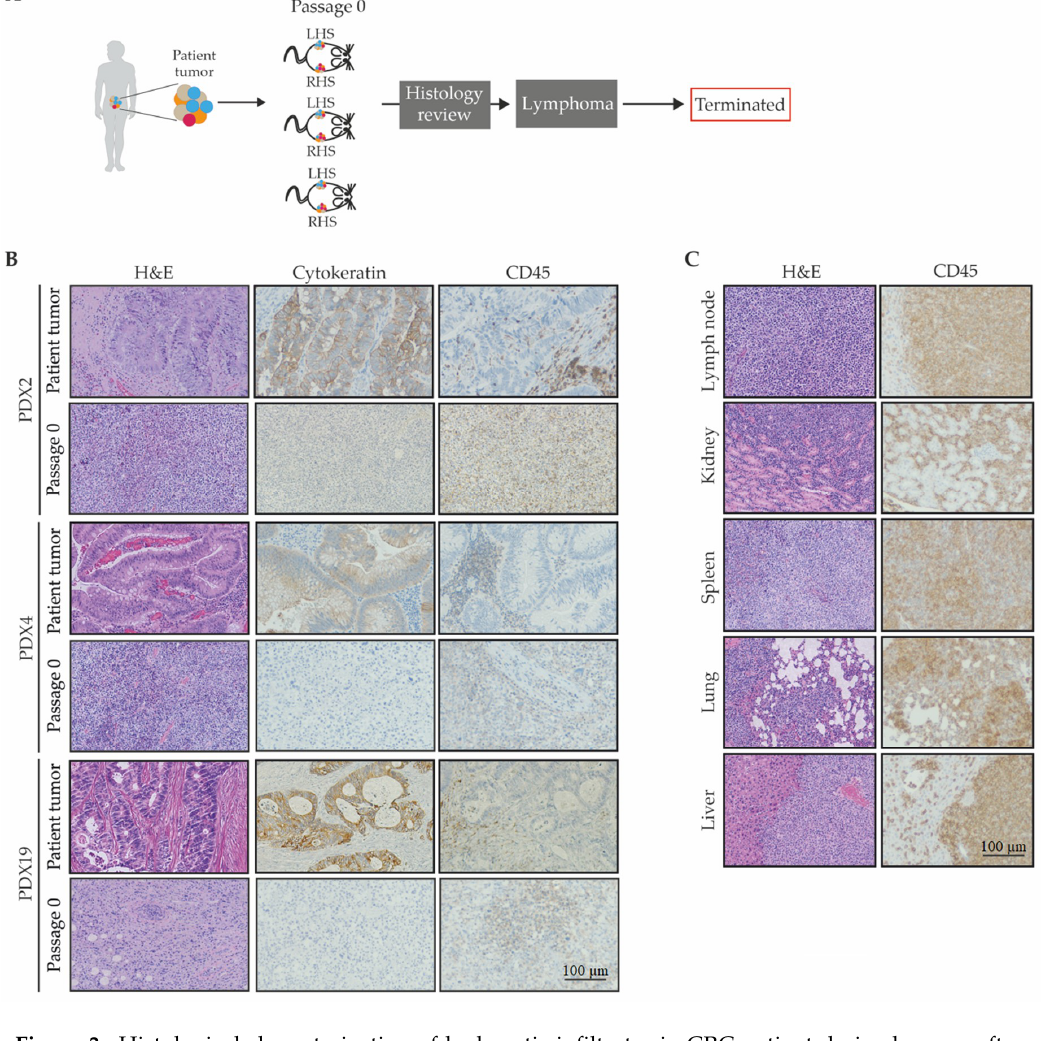
Figure 3. Histological characterization of leukocytic infiltrates in CRC patient-derived xenografts. ( A ) Schematic representation of the histological review of PDXs; ( B ) representative H&E, pan-cytokeratin, and human CD45 immunohistochemistry images of P0 PDX tumors from the indicated PDX line; ( C ) representative H&E and CD45 immunohistochemistry images of metastatic tumors; scale bar for B-C is 100 µm and applies to all images.